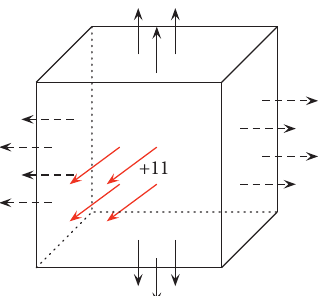
Figure 1: DOFs when k � 1, 4 for vertical faces and 3 for horizontal